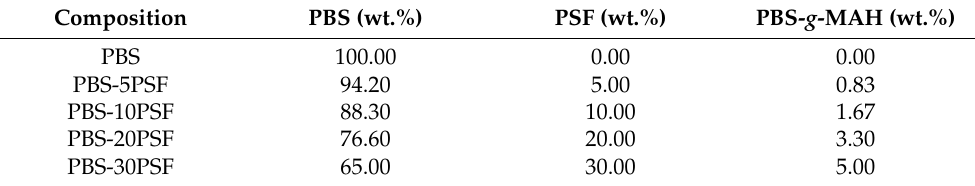
Table 6. Summary of compositions according to the weight content (wt.%) of poly(butylene succi- nate) (PBS), pistachio shell flour (PSF), and poly(butylene succinate) grafted with maleic anhydride (PBS- g